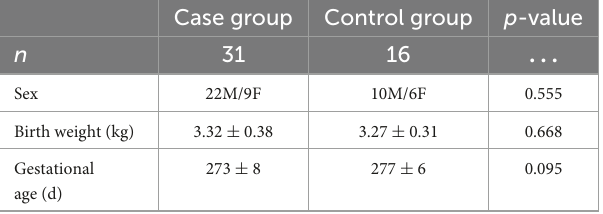
following settings: TR = 50 ms, TE = 3.1 ms, FOV = 240 × 240 mm 2 , matrix = 128 × 128, NEX = 1, slice thickness = 5 mm,